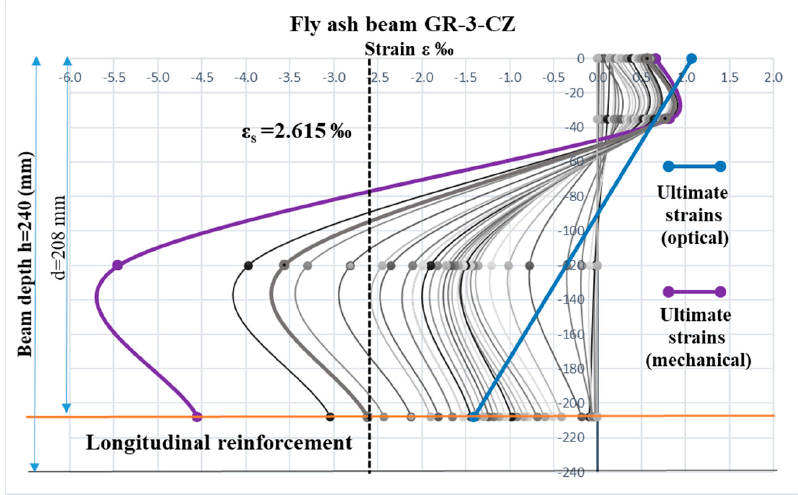
Figure 8. Experimental strains distribution at mid-span section according to mechanical and optical methods for fly ash beam (GR-3-CZ).